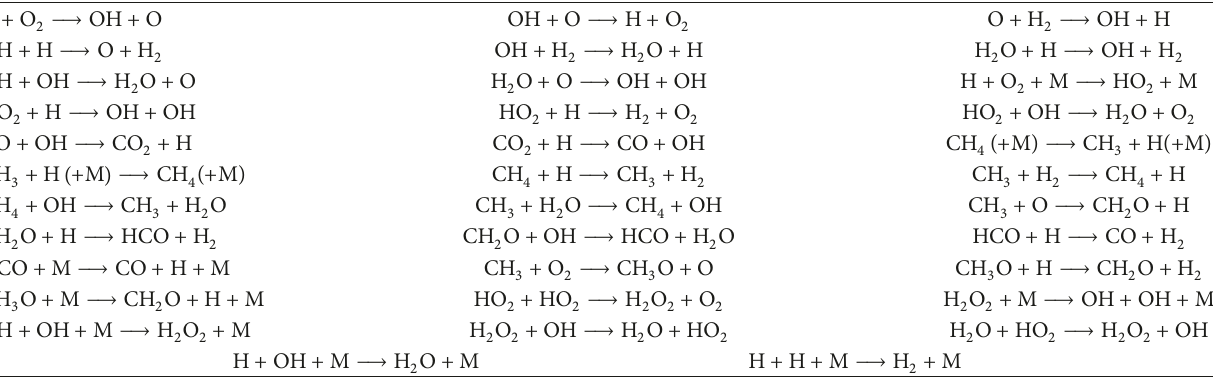
Table 1: Reactions of reduced